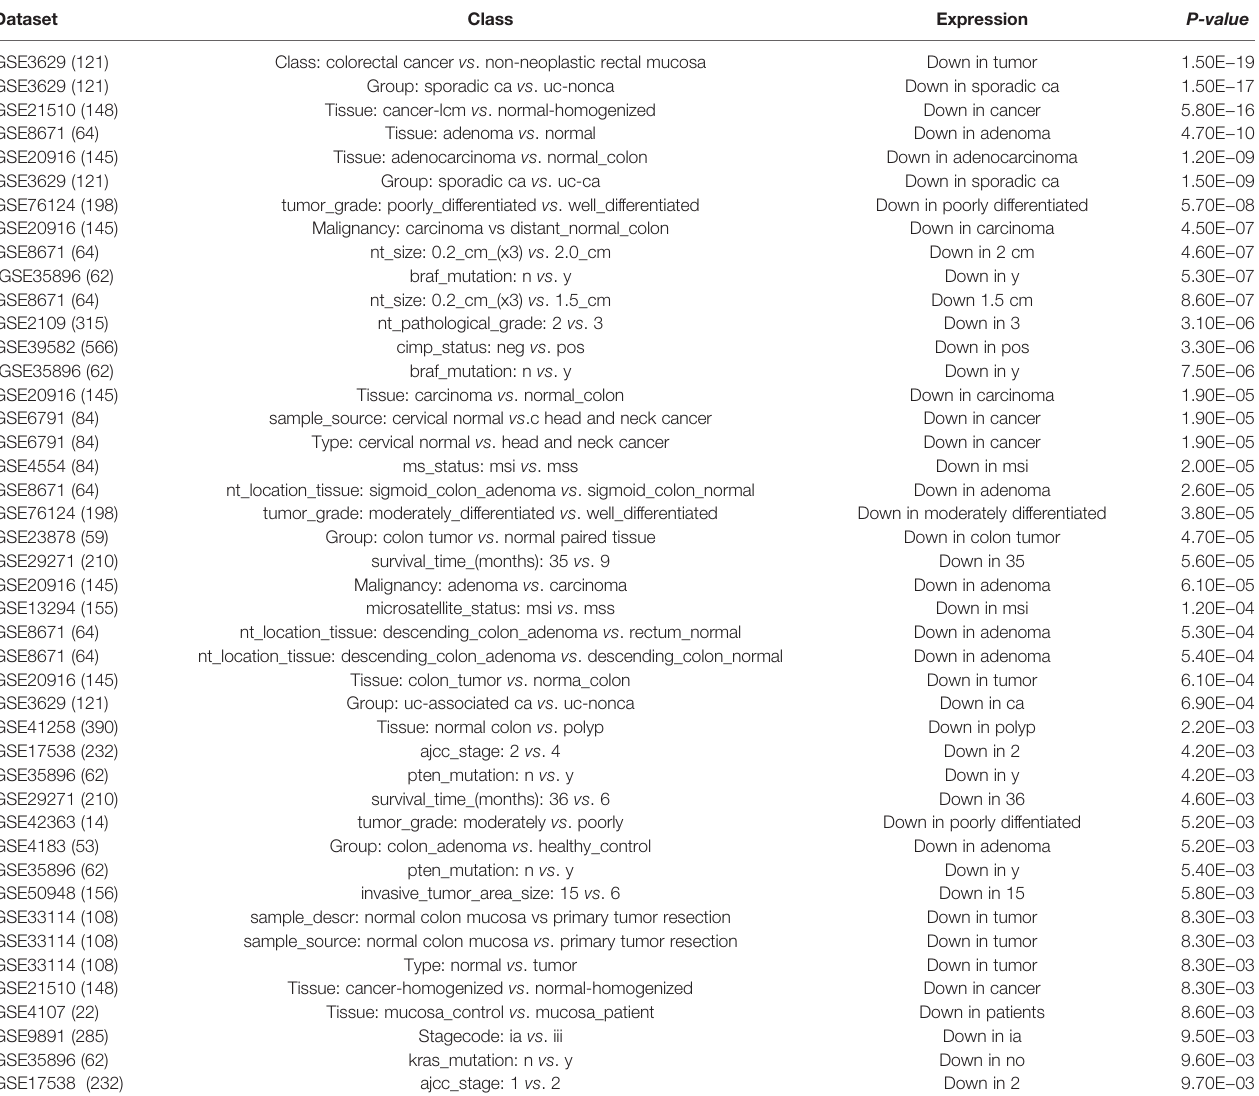
TABLE 3 | LINC00483 dysregulation in several expression datasets.